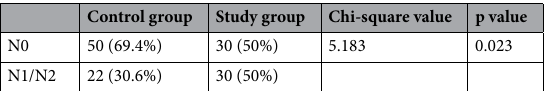
Table 3. The effect of carbon nanoparticle suspension on nodal staging.